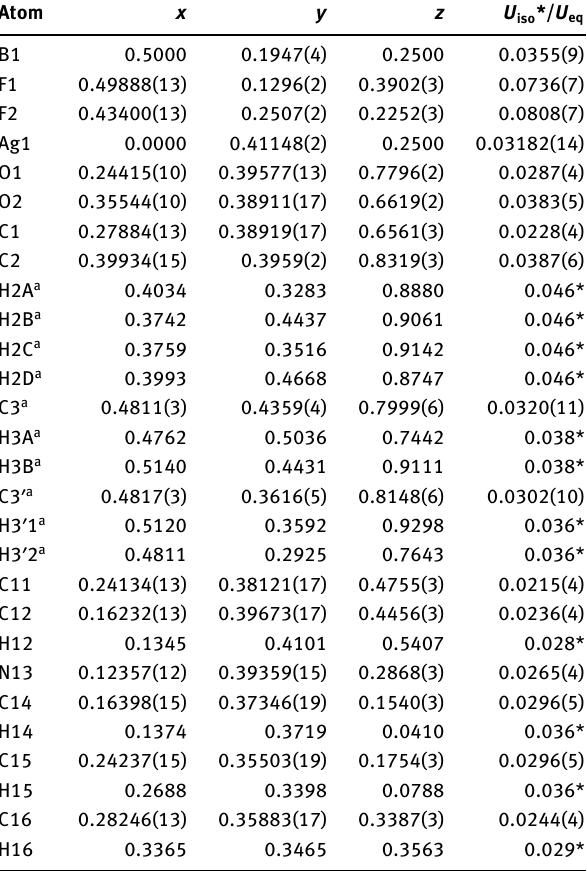
Table 2: Fractional atomic coordinates and isotropic or equivalent isotropic displacement parameters (Å 2 ).